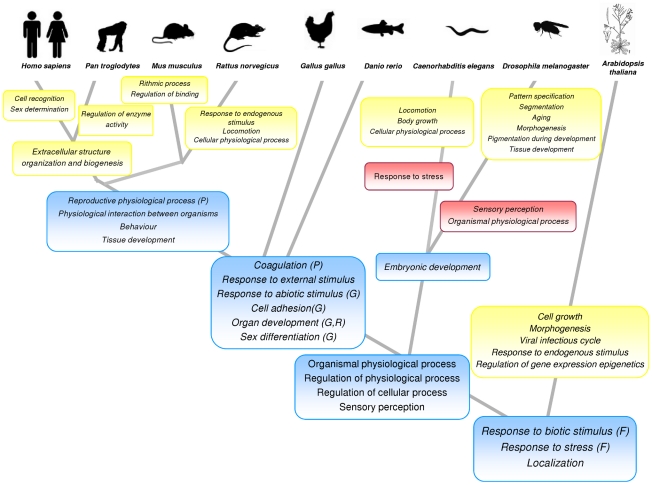
Distribution of functions present in functional neighborhoods along the phylogeny.The point at which a function makes up a functional neighborhood has been deduced from the species sharing functional clusters with this particular GO term. Boxes in yellow contain GO terms unique to taxa, boxes in blue contain GO terms common to clades and boxes in pink contain GO terms lost in these lineages. In the figure, terms labeled with P were not found in ape, with G: were not found in chicken, with R were not found in rat and with F were not found in fish.